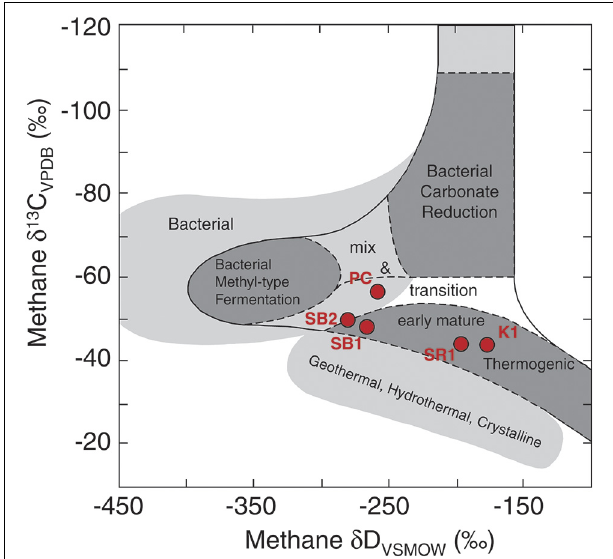
FIGURE 5 | Carbon and hydrogen isotopic compositions of dissolved methane samples from Prince Creek Formation, and Schrader Bluff, Kuparuk, and Sag River reservoirs. A shift toward the left for Schrader Bluff samples indicates a significant portion of biogenic methane was produced from the acetoclastic (“fermentation”) pathway. This figure was adapted from Whiticar